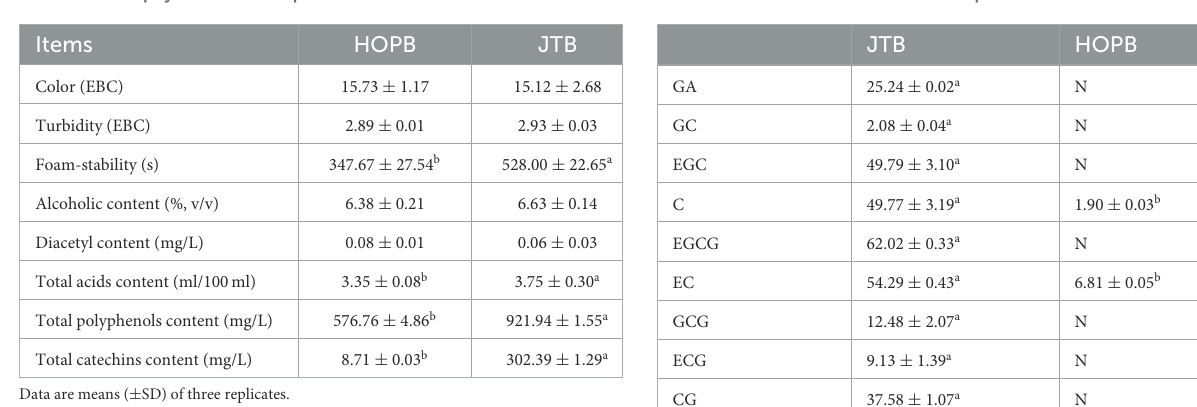
TABLE 1 Basic physico-chemical parameters of the beer. TABLE 2 Content of catechin-like compounds in